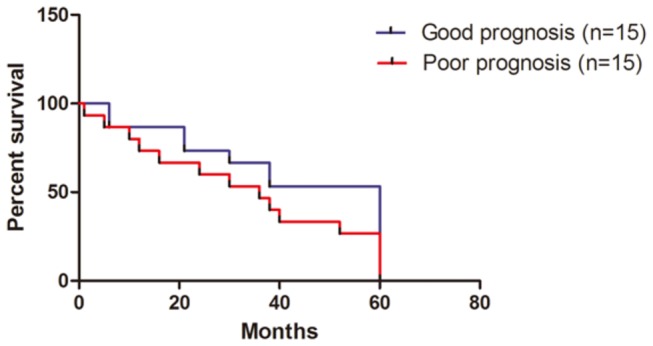
Survival curves of patients in two groups classified by the 74 genes microarray.The x-axis indicated the months within which the patients still alive. The y-axis indicated that the percentage of alive patients (including the ones with metastasis or recurrence).